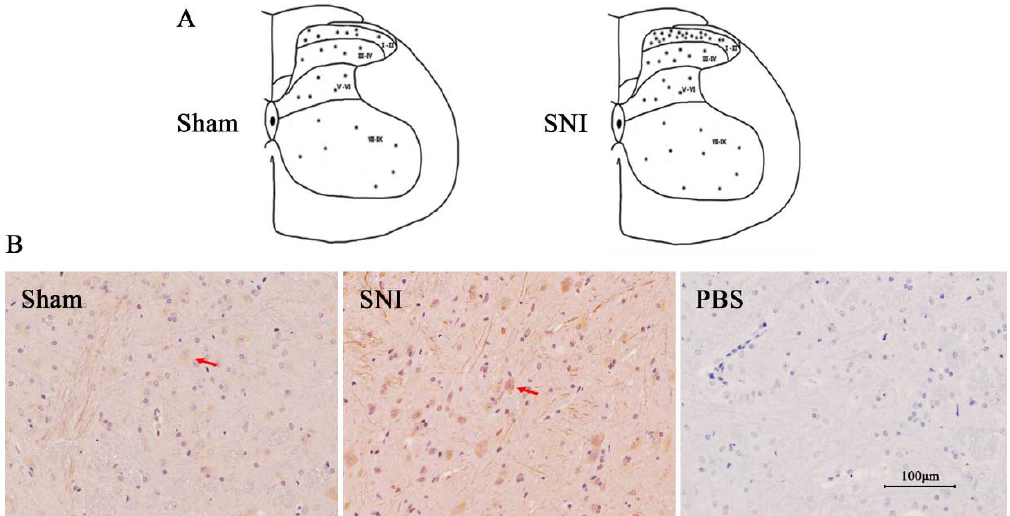
Figure 1. The distribution of Syt ‐ 1 immunoreactive cells in the spinal cord dorsal horn (SCDH). ( A,B) The sketches and tissues (in laminae I ‐ II) showed that SNI resulted in increased Syt ‐ 1 immunoreactive (Syt ‐ 1 ‐ IR), mainly in the laminae I ‐ II of the SCDH. B shows the representative of immunohistochemistry from 3 animals. Red arrows show Syt ‐ 1 positive cells. Scale bars, 100 μ m.